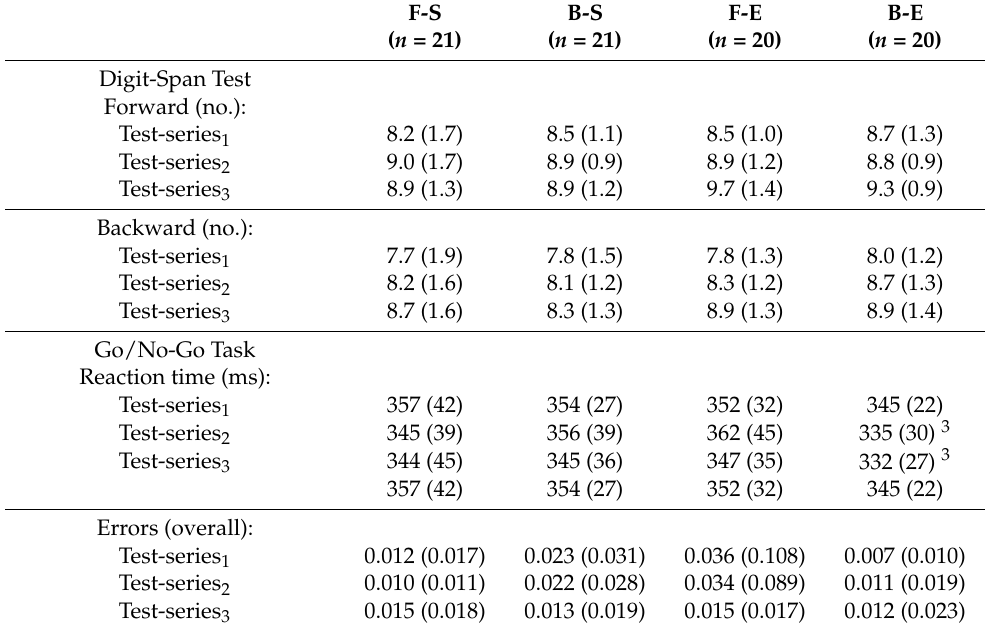
Table 3. Maximum number of digits memorized in a forward and backward sequence in the Digit- Span Test, and reaction times and number of errors committed in the Go/No-Go Task across the